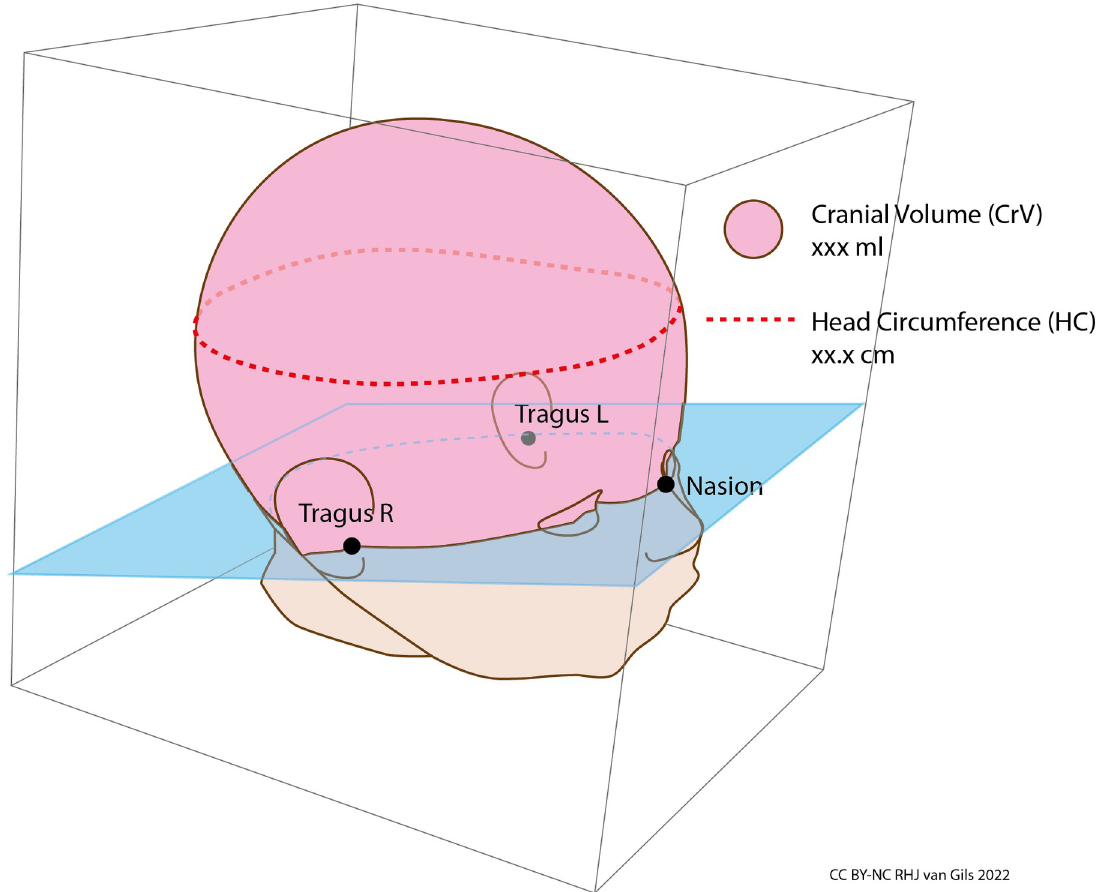
Fig 4. 3D Cranial volume (CrV) measurement could provide more clinically relevant growth data than 2D HC measurement. CrV is mostly defined by the volume above a virtual plane through three anatomical points: tragus left, tragus right and nasion. CrV growth reference charts are being developed, with CrV expressed in millilitres (ml) in a round number. CrV measuring instruments with an accuracy of 1 ml should be clinically